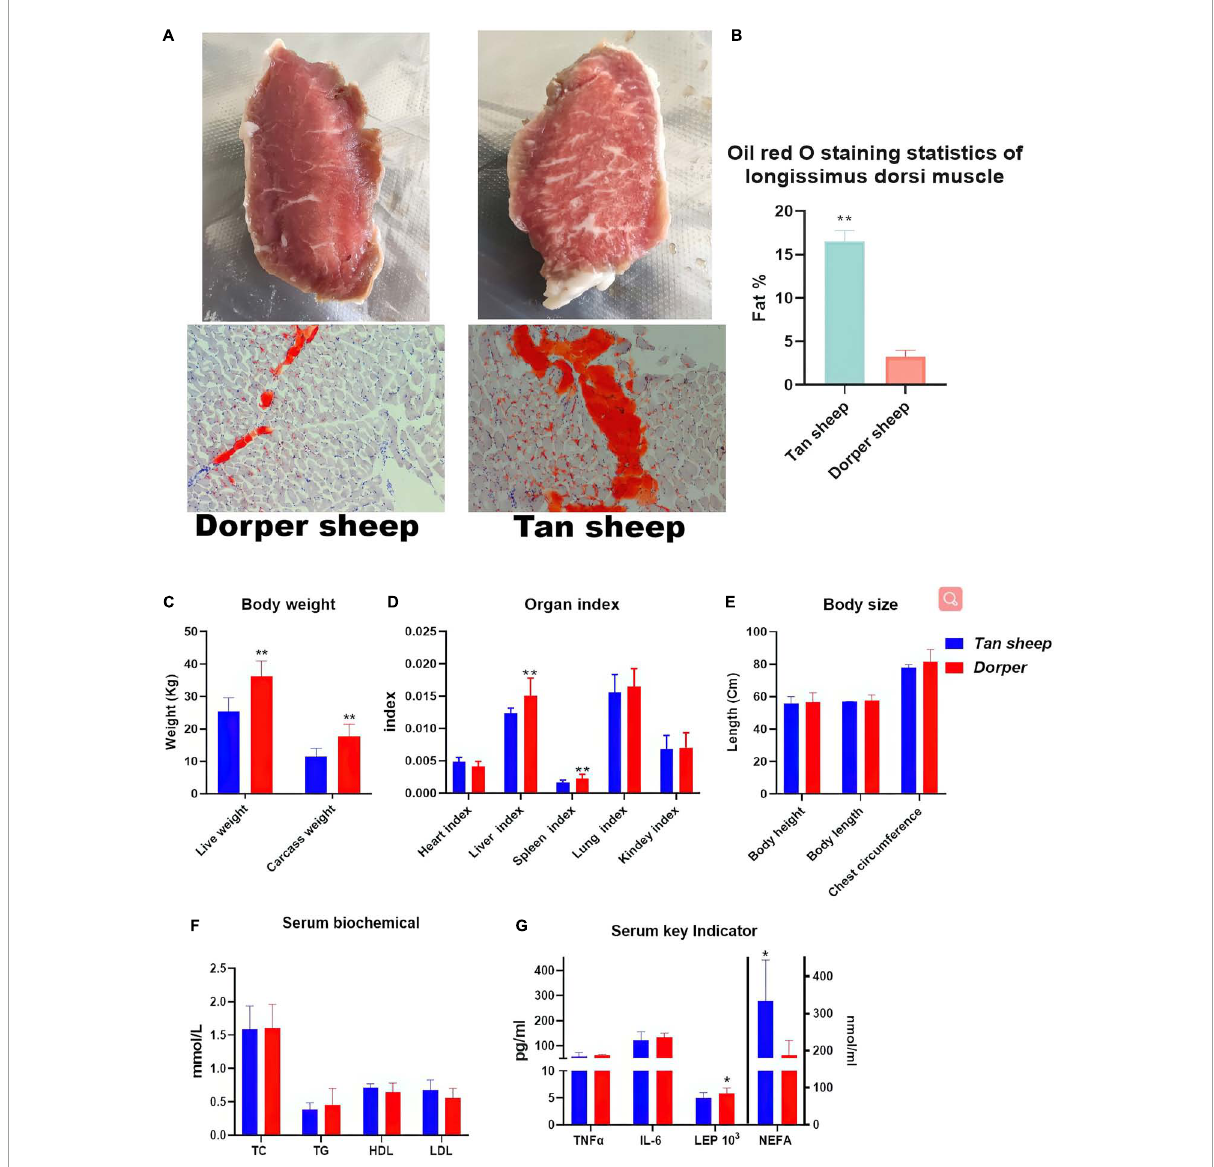
FIGURE1 Phenotypic Trait Statistics. (A) The appearance map of the longest dorsal muscle of Dorper sheep (left) and Tan sheep (right) and the results of oil red O staining (bottom). (B) Image J statistics on Oil Red O staining results. ( n = 6) (C–E) Statistical results of body weight, organ index and body size between breeds. (F,G) Statistical results of serum biochemistry and key indicator. *means P- value < 0.05, **means P- value <